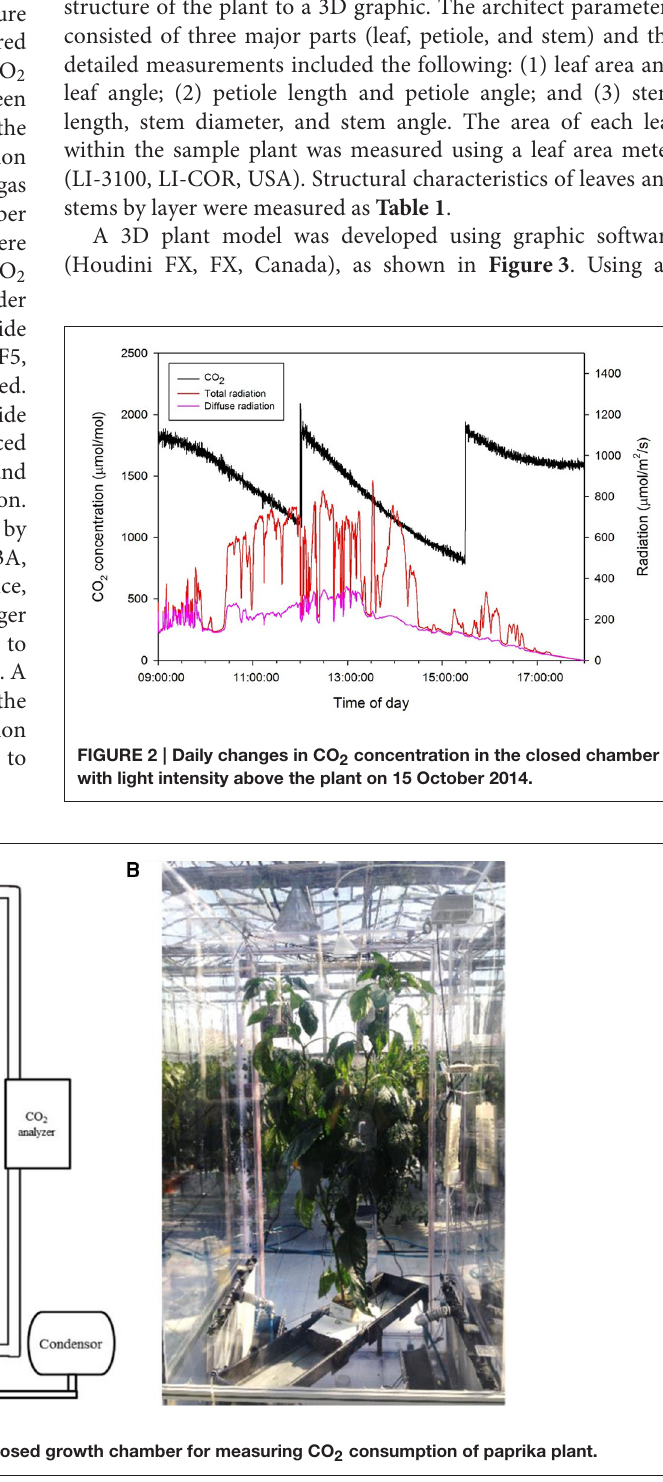
Frontiers in Plant Science |